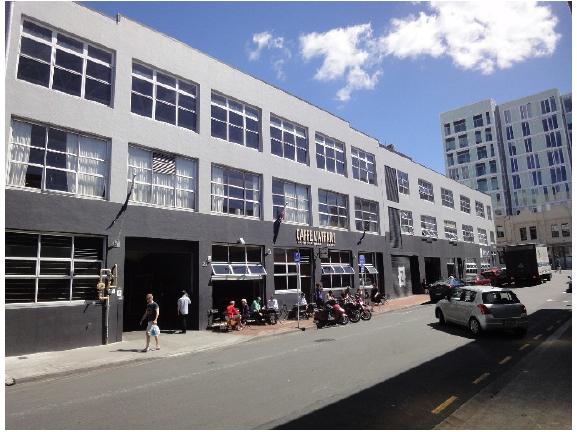
Figure 5. The relationship between these two buildings is seamless and was well-liked by the survey